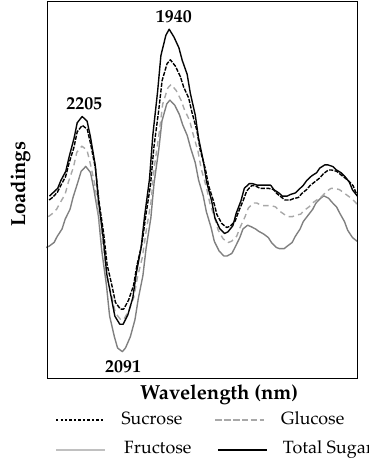
Figure 4. PLSR loading vectors for the first latent variable in the calibration models for sucrose, glucose, fructose, and total sugar content in ground breakfast cereals.